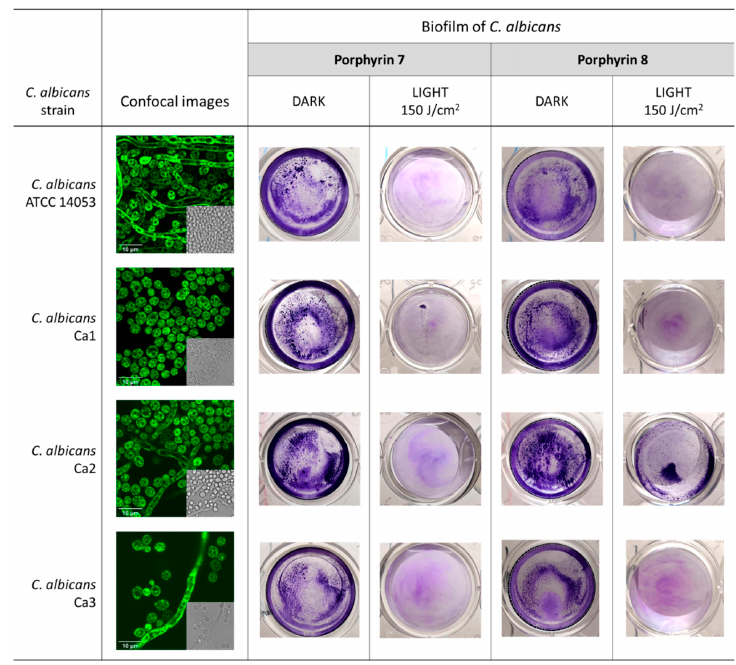
Figure 7. Inhibition of biofilm formation of four Candida albicans strains (ATCC 14053, Ca1, Ca2, and Ca3) by photodynamic inactivation with Porphyrins 7 and 8 . Porphyrins were activated by 410 nm blue light, 100 mW/cm 2 for 25 min, corresponding to 150 J/cm 2 . Images of crystal violet stained biofilm are presented. In the second column, confocal images of yeast strains are reported (scale bar: 10 µm).